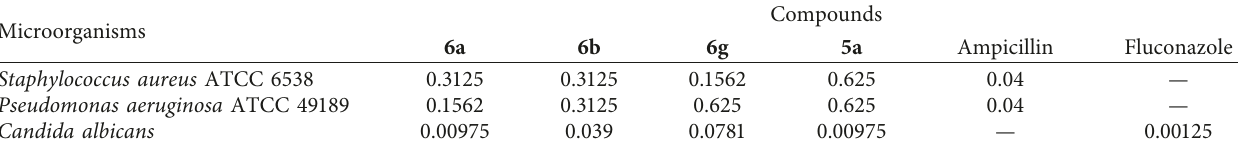
Table 5: Determination of the minimum inhibitory concentrations (MICs) expressed in